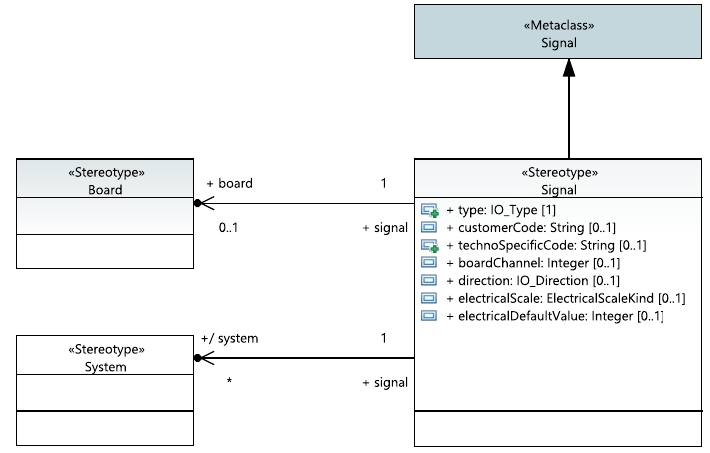
Figure 9. Meta-model of functional and physical